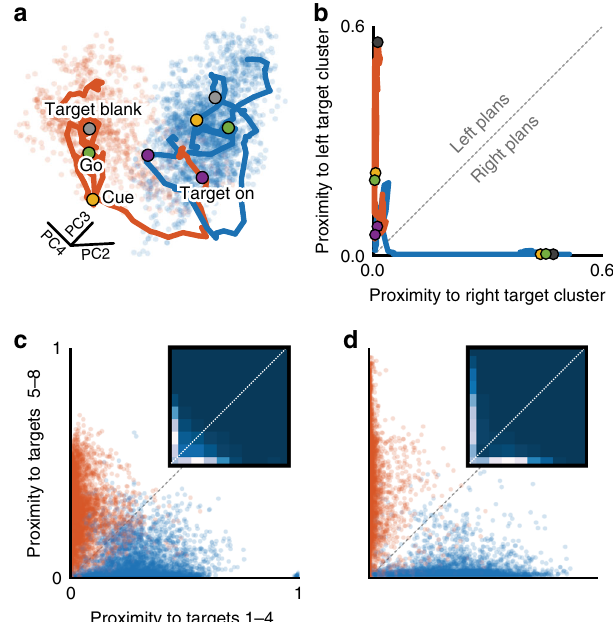
Fig. 3 Low-dimensional neural states on 1-Target trials. a Low-dimensional neural state trajectories throughout individual left (red) and right (blue) 1- Target trials. Blue and red clusters re fl ect all neural states visited during 1- Target trials to rightward and leftward targets, respectively. Colored, labeled markers indicate the fi rst time points in each trial epoch. b Proximity plot ( x - axis: proximity to the rightward cluster; y -axis: proximity to leftward cluster) for the example trials from a , with corresponding trial event markers. c Proximity plot of Target Blank activity over all 1-Target trials, monkey C. Inset density plot shows that most points lie along the x - and y